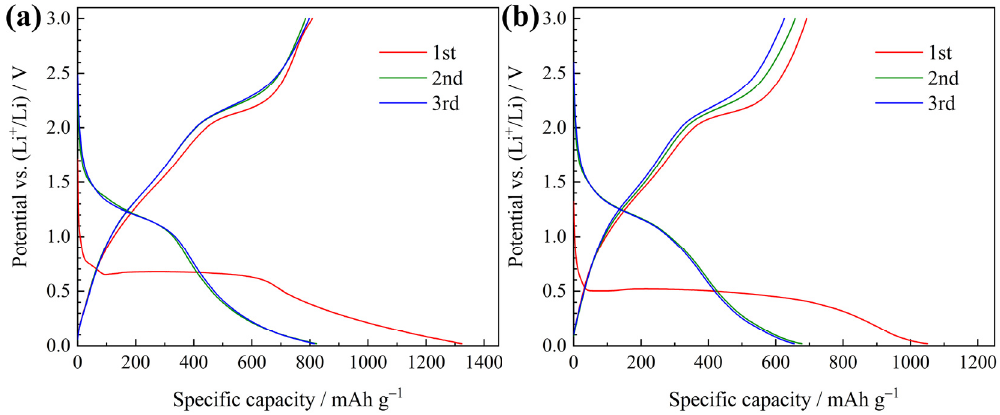
Figure 6. Galvanostatic discharge-charge curves of ( a ) the NiO / C electrode and ( b ) NiO electrode.